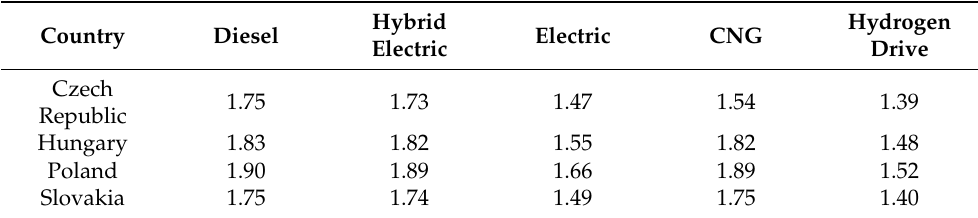
Table 17. Cost of a vehicle-kilometer of mega buses (18 m) with different drive types in the V4 countries, calculated on the basis of the last year of operation (2035) ( € ). Country Diesel